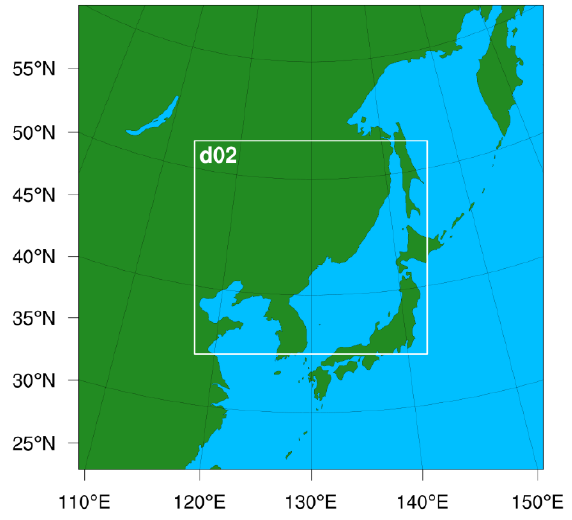
Figure 1. Two nested model domains (D01,D02) and their horizontal resolutions (9 km and 3 km respectively).